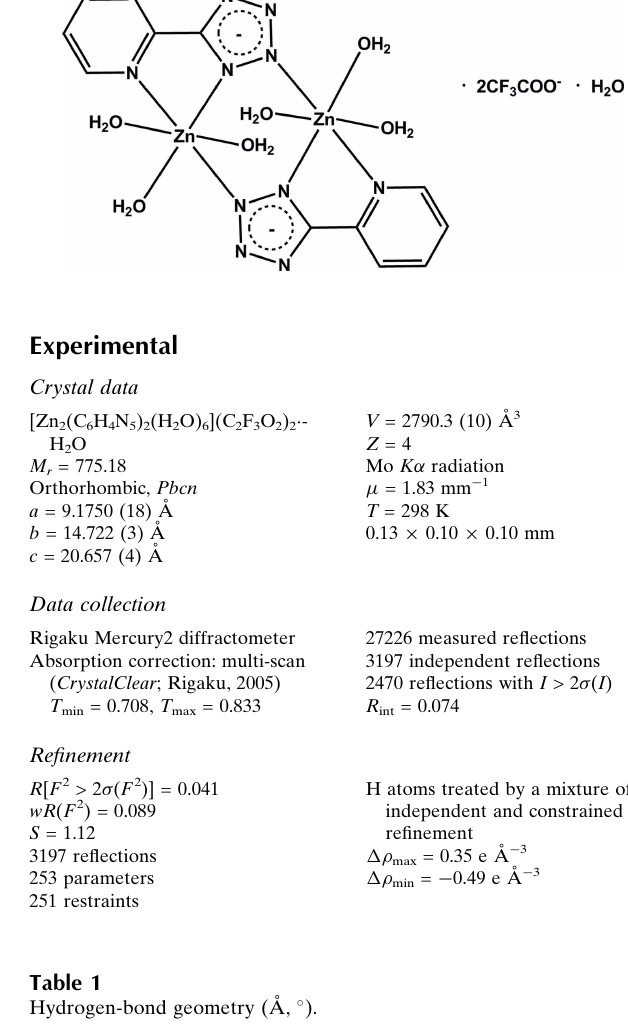
Hydrogen-bond geometry (A˚ , (cid:5) ). D —H (cid:2)(cid:2)(cid:2)